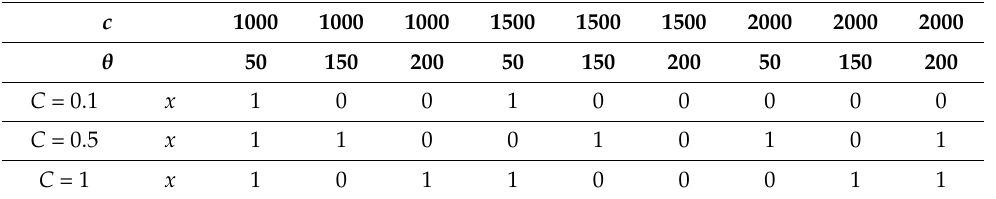
Table 10. The GEM solutions ( n =